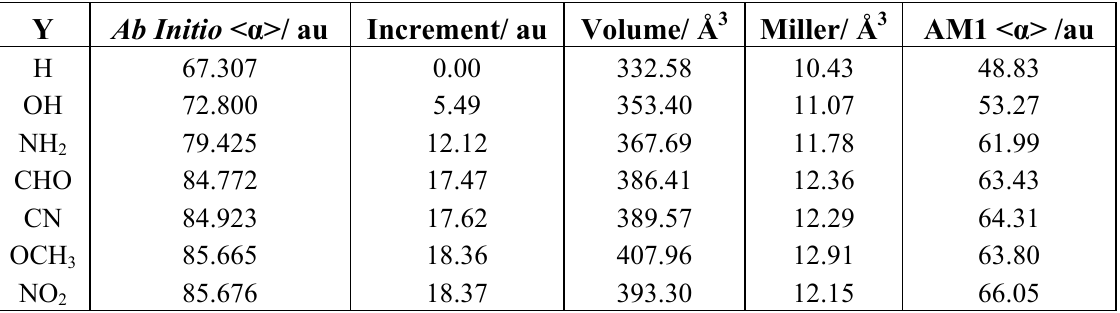
Table 2 . Various quantities for Series I with X = H